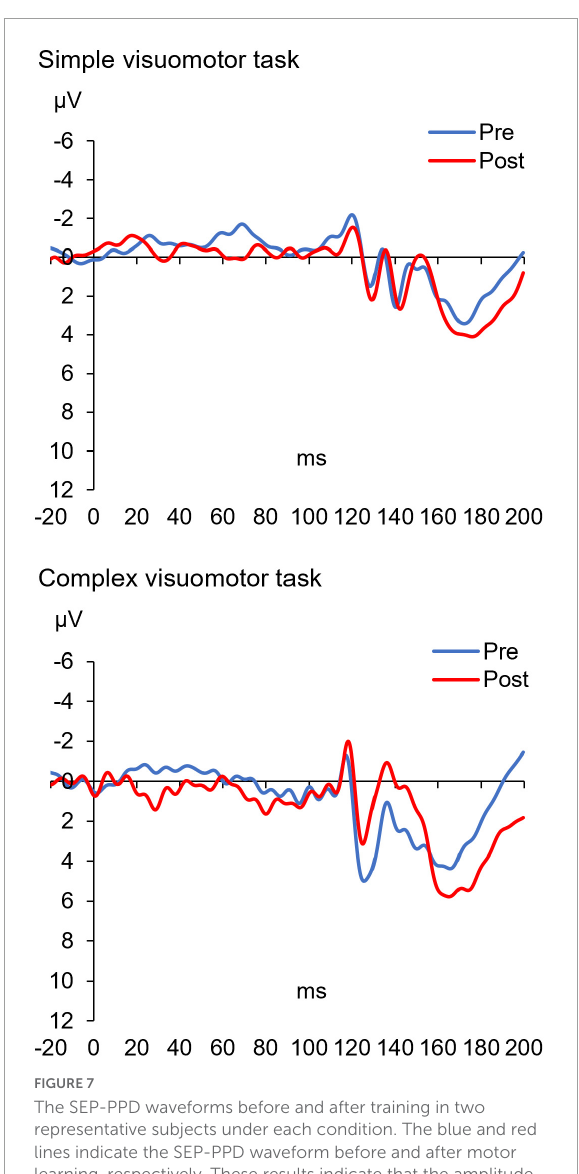
FIGURE7 The SEP-PPD waveforms before and after training in two representative subjects under each condition. The blue and red lines indicate the SEP-PPD waveform before and after motor learning, respectively. These results indicate that the amplitude (N20/P25) of the SEP-PPD waveform after motor learning did not change in the simple visuomotor task but decreased in the complex visuomotor task.